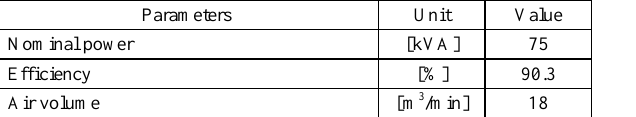
Fig. 2. Construction of the CHP 64